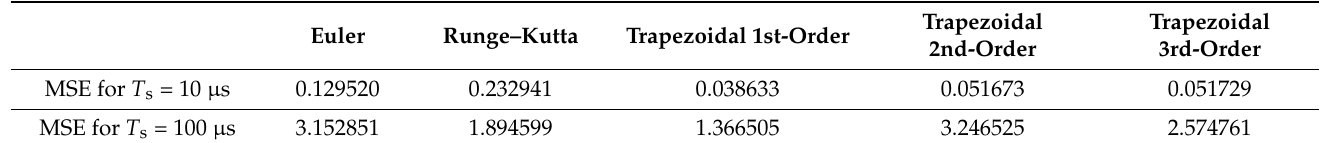
Table 3. Mean square error between i s and i ref in phase a for the evaluation of numerical methods in the predictive controller.